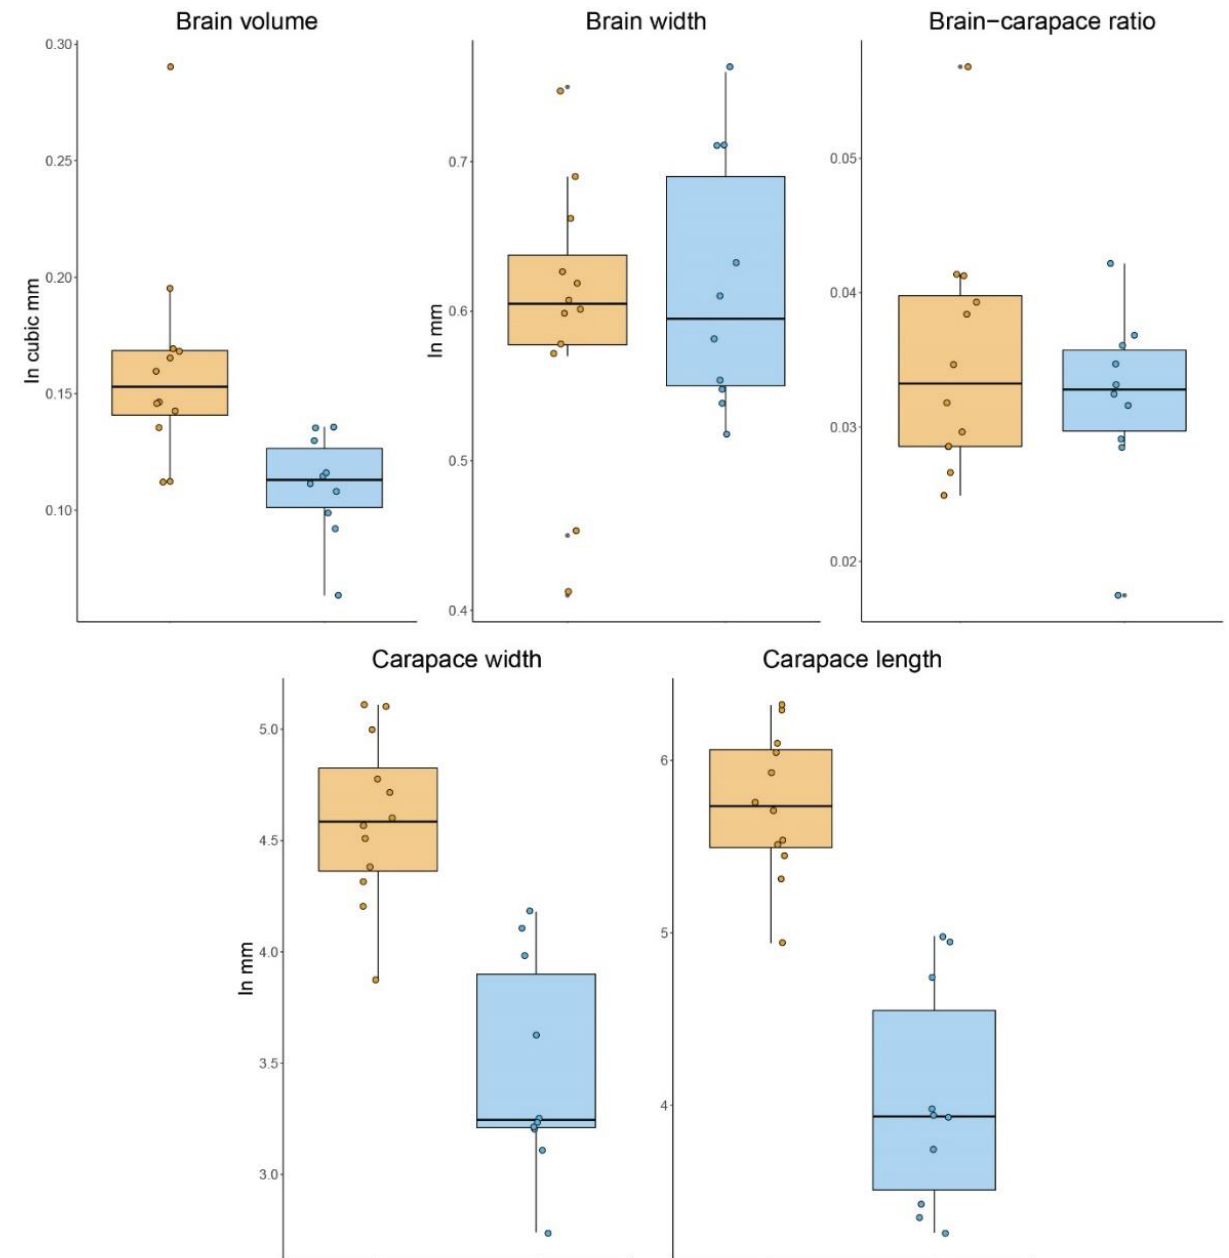
Figure 1. Volumetric and size comparisons. Boxplots comparing the volume and size variation in both groups. Fresh material ( New ) is shown in dark yellow and legacy material ( Old ) in blue. Note that although there is a considerable variation in absolute brain volume and carapace size, the brain width and brain–carapace ratio are not significantly different between the groups.